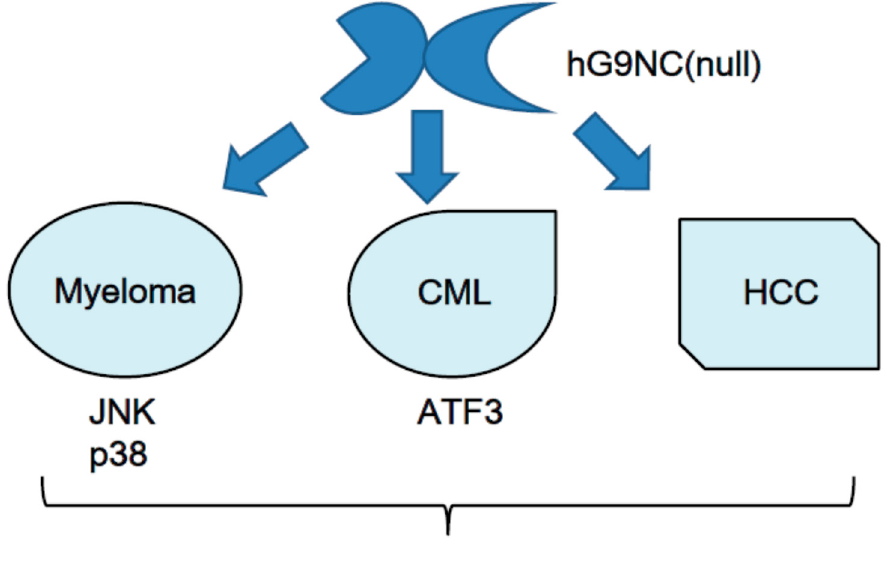
Figure 5. Human recombinant galectin-9 induces intrinsic apoptosis of cancer involving endoplasmic reticulum. The receptors for galectin-9 lacking a linker peptide, hG9NC (null), in the three malignancies remain unknown.